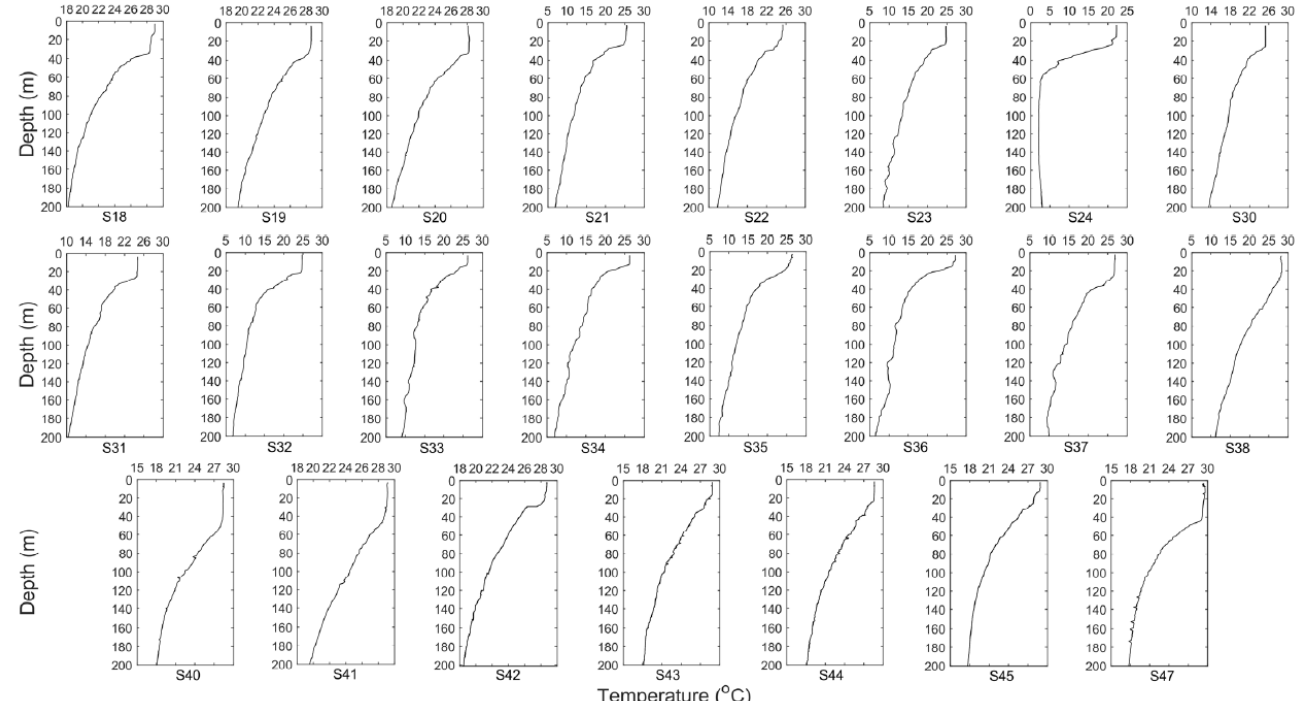
Figure 4. The water temperature profiles collected by CTD.